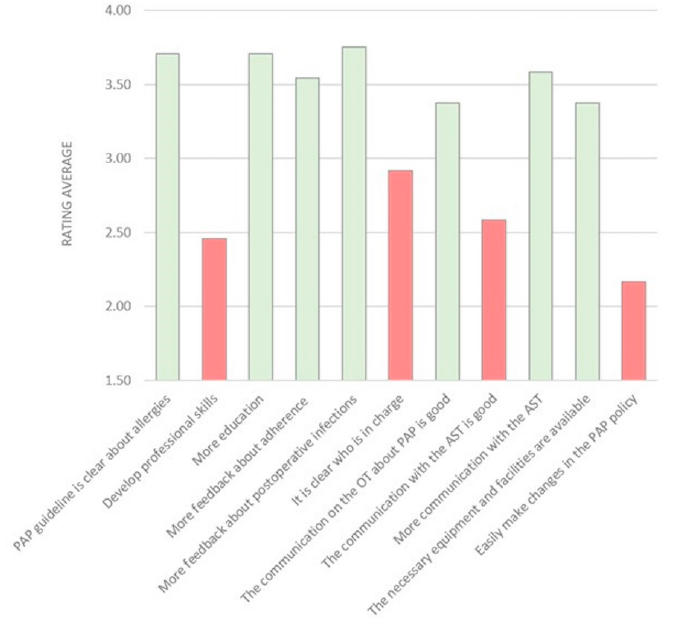
Figure 1. Rating averages of the statements in the survey. Red represents disagreement about the statement and green represents agreement about the statement. N respondents is 24.